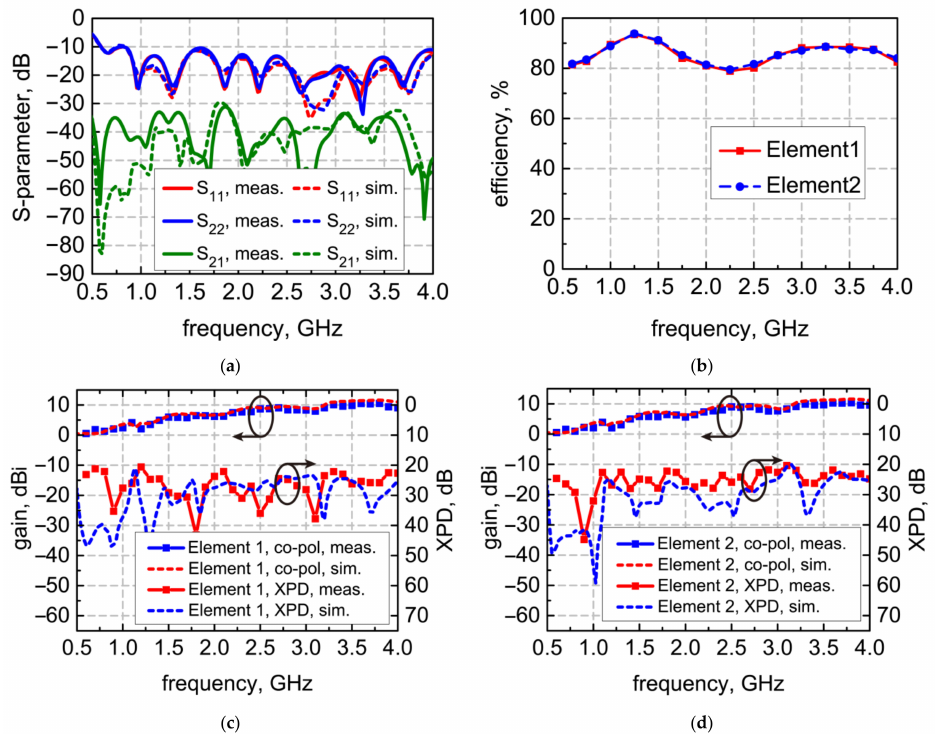
Figure 8. The simulated and measured results of the proposed DP-DSATSA. ( a ) Measured and simulated S-parameters; ( b ) efficiency of elements in the DP-DSATSA; ( c ) measured and simulated gain of Element 1 in the DP-DSATSA; ( d ) measured and simulated gain of Element 2 in the DP-